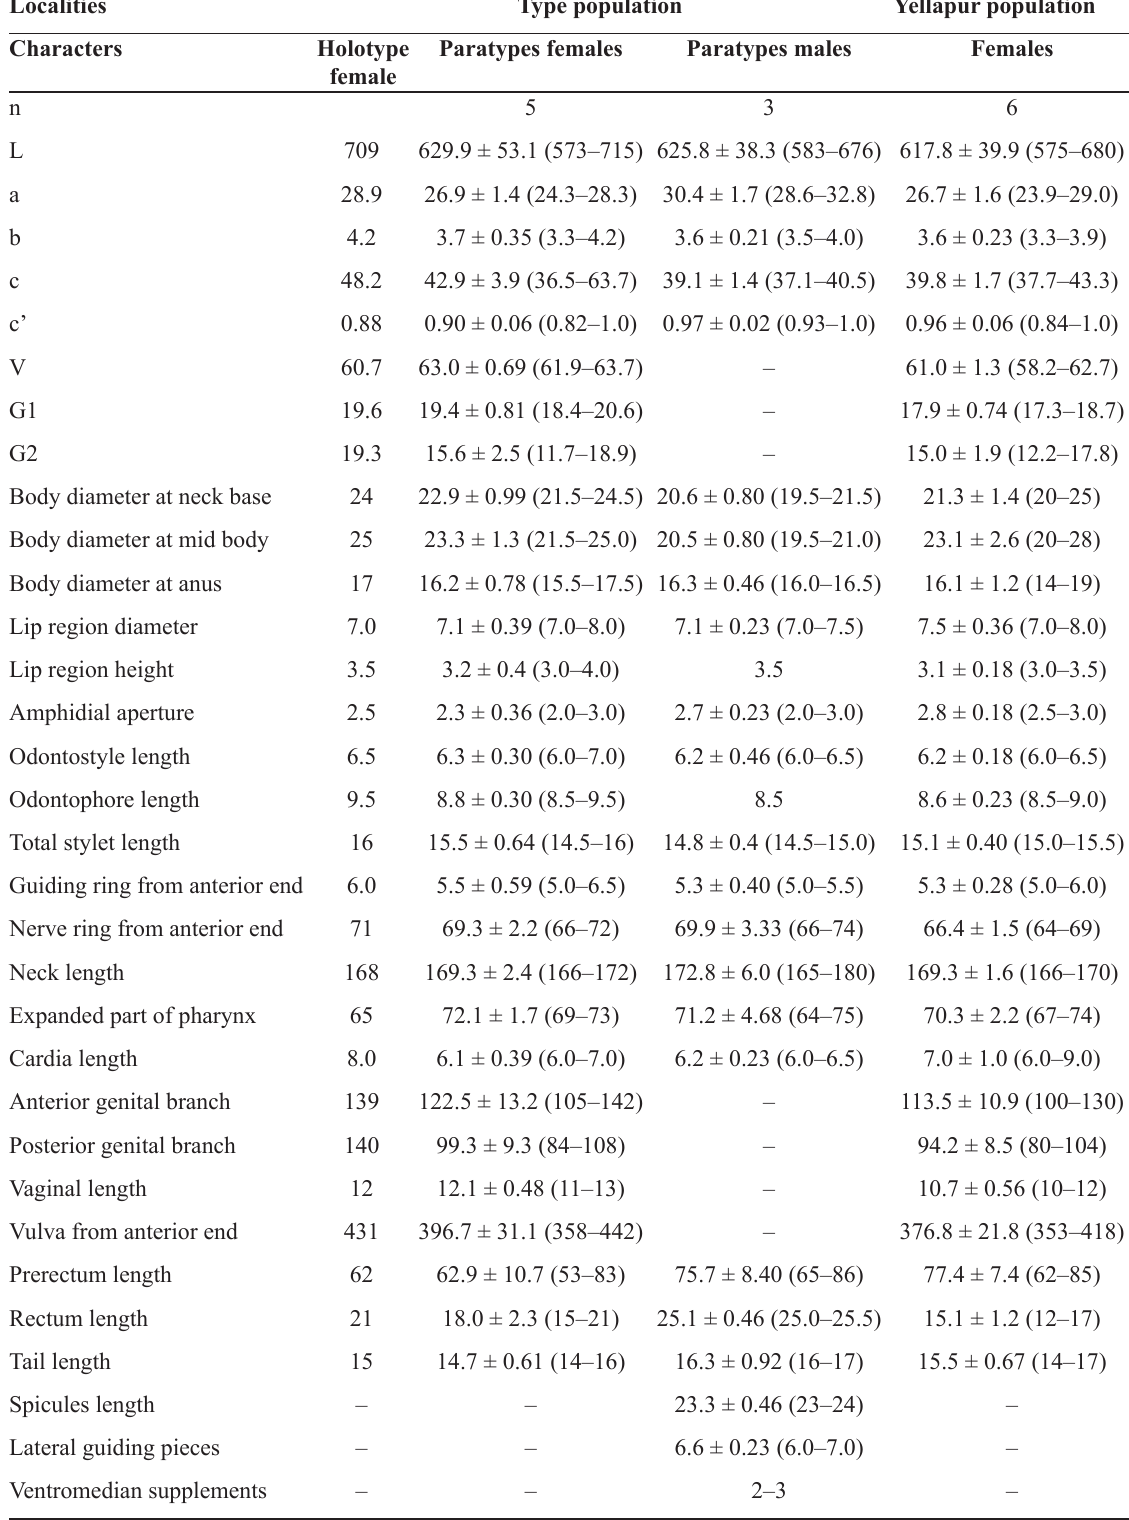
Table 7. Measurements of Tylencholaimus shamimi sp. nov. All measurements are in µm and in the form: mean ± s.d.